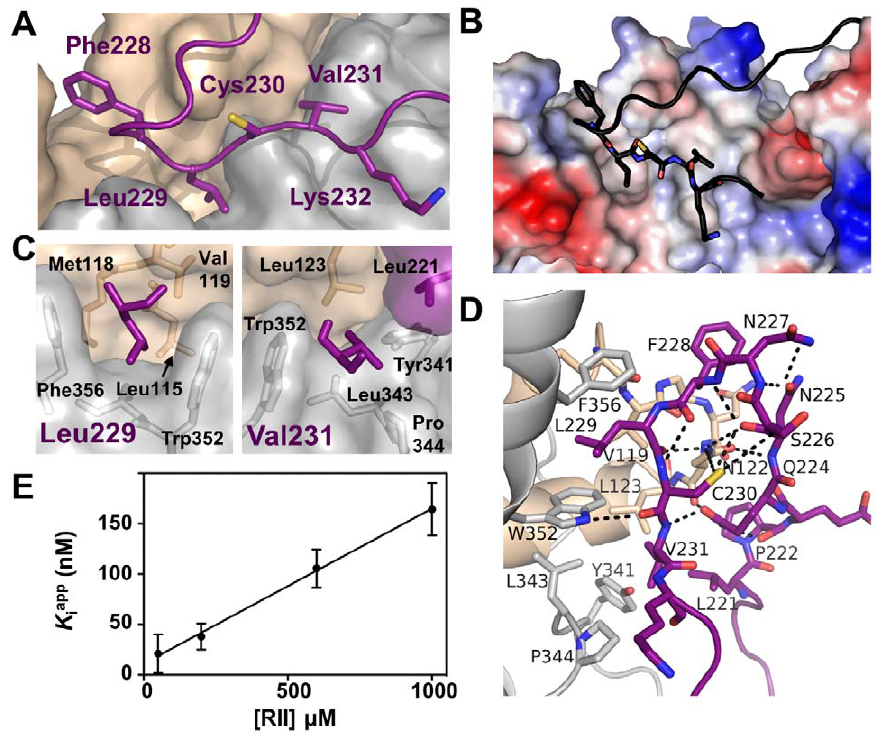
Figure 4. CN-A238L interactions: The LxVP substrate binding site. (A) Close-up view of the CN W LxVP substrate binding site. (B) Electrostatic surface potential of the A238L-CN complex, highlighting the hydrophobic nature of the W LxVP binding groove. (C) CN residues that make up the Leu229 hydrophobic binding pocket (left) and the Val231 hydrophobic binding pocket (right). (D) Electrostatic intermolecular interactions between CN and A238L and intramolecular interactions at the A238L kink, which coordinate A238L for W LxVP binding. (E) Secondary plot of K iapp as a function of [RII] for inhibition of CN by A238L PKIIITmut , which retains the FLCVK site. Data show a linear dependence characteristic of competitive inhibition, with K i =15 nM. Points represent averages 6 s.e.m. from three independent experiments.